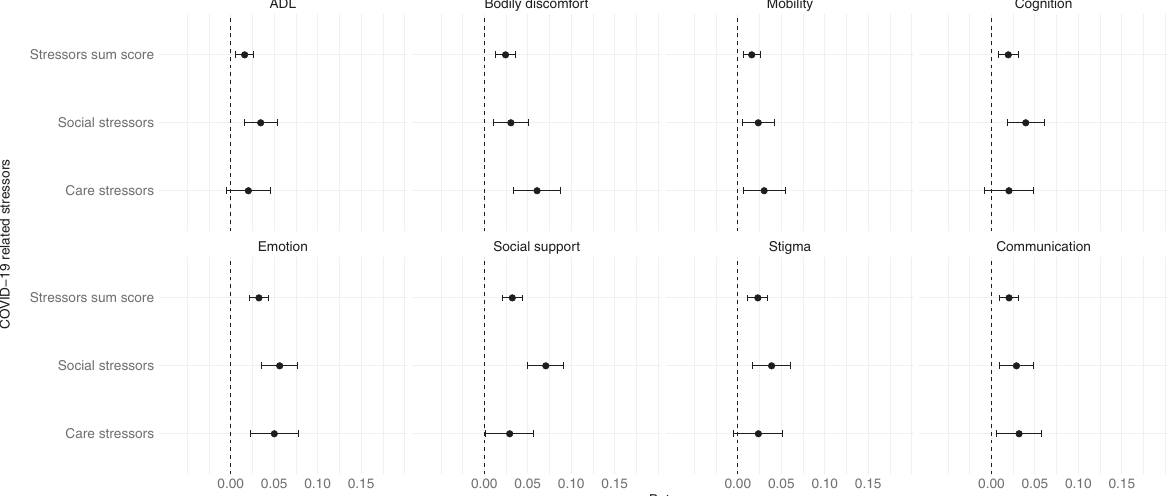
Fig. 4 Association between sum scores of COVID-19 related stressors and quality of life. Points represent the regression coef fi cients of the linear models and bars the 95% con fi dence intervals. The PDQ-39 domains were standardized in order to make the estimates comparable. Higher PDQ-39 domain scores represent worse experienced quality of life. Models were adjusted for sex, age, disease duration, presence of comorbidities, education, living situation, region, and date. N =